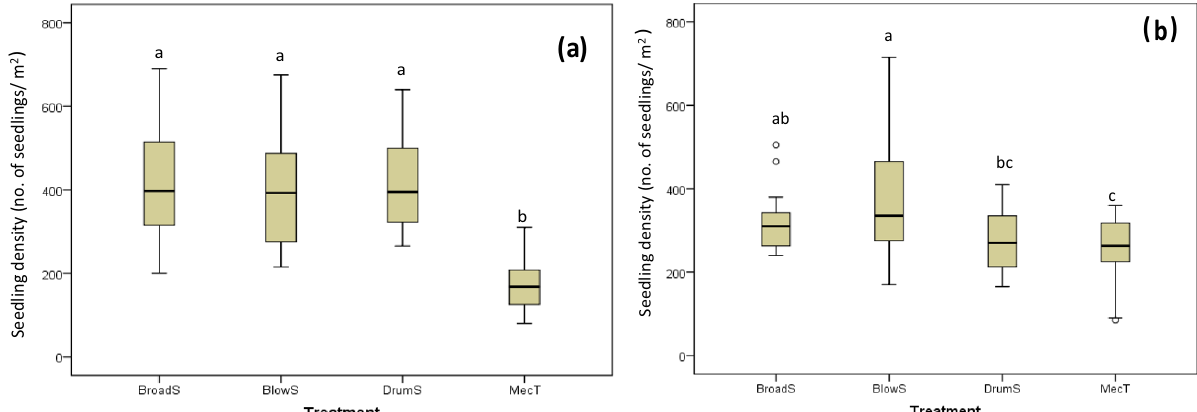
Figure 3. Seedling density (no. of seedlings m -2 ) 7 days after sowing/transplanting of the four different crop establishment treatments in Can Tho, Vietnam, during the Winter-Spring ( A ) and Summer-Autumn ( B ) seasons. Box plots with the same letters are not significantly different at the 0.05 level of significance following pairwise comparisons.